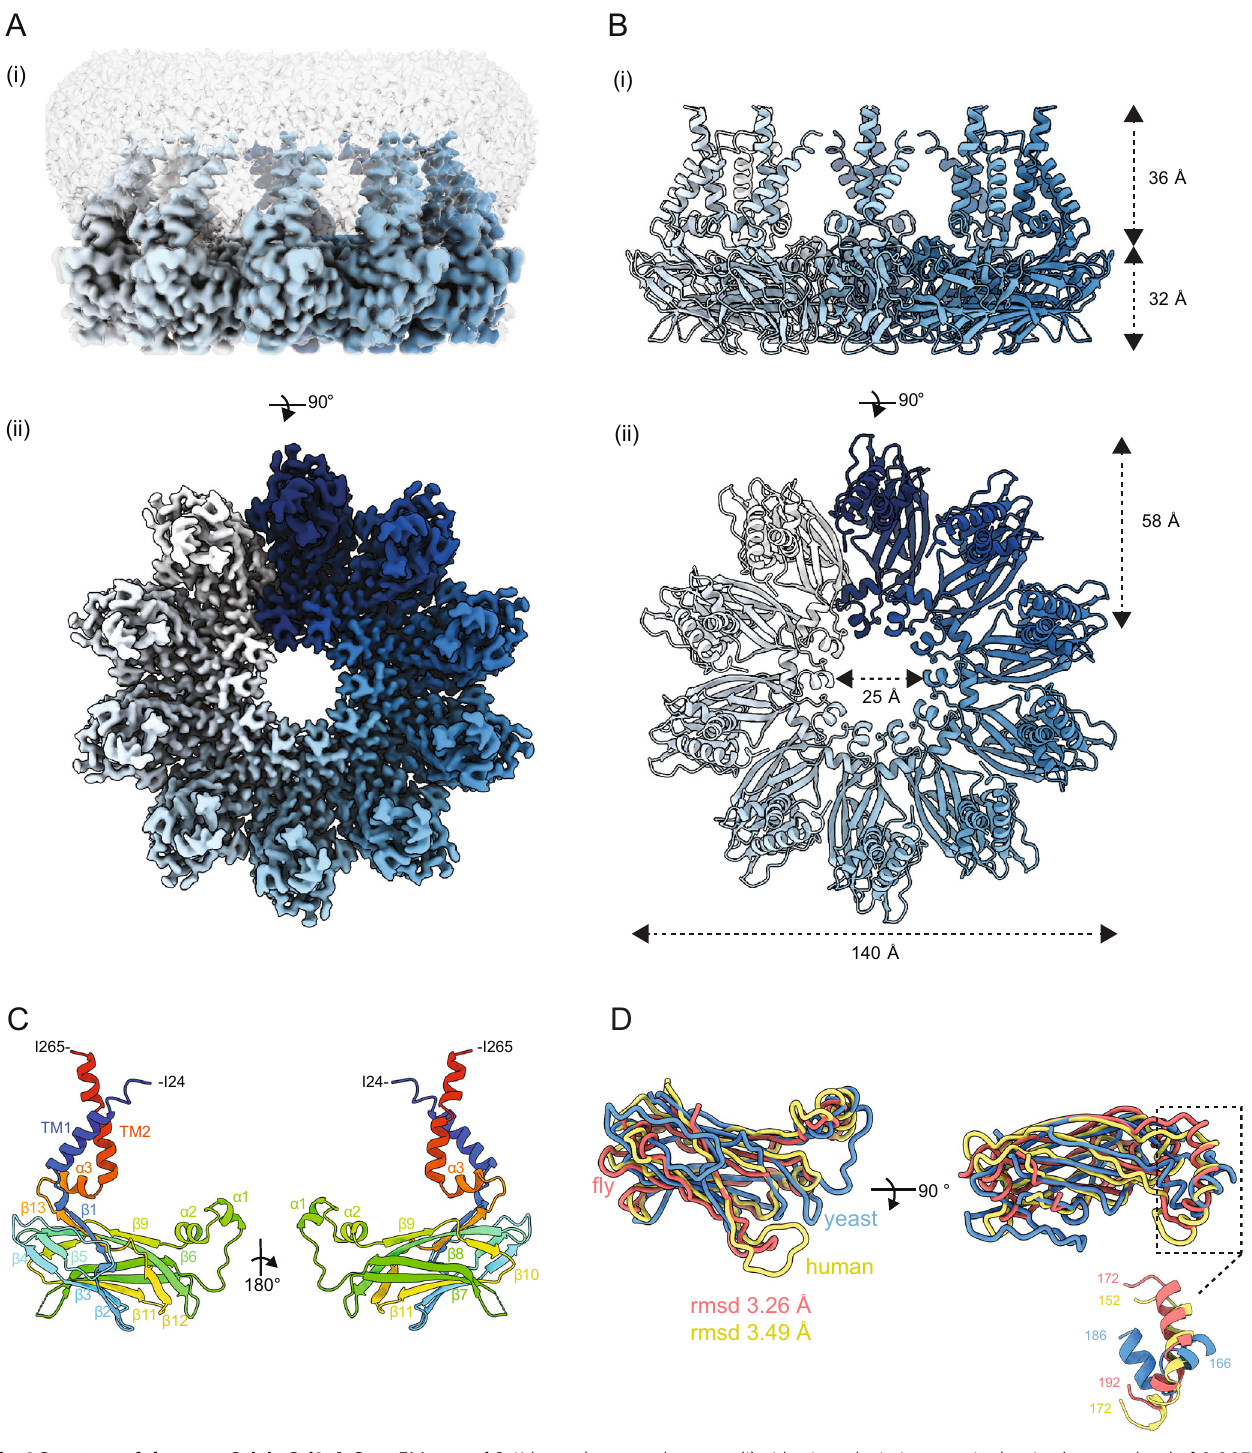
Fig. 1 Structure of the yeast Seipin Sei1. A Cryo-EM map of Sei1 homodecamer shown as (i) side view, depicting protein density (contour level of 0.007) with each Sei1 protomer colored in shades of blue, and the surrounding detergent micelle shown in transparent gray (contour level of 0.005) or (ii) 90- degree rotated view looking down from the cytosol, with detergent micelle omitted for clarity (contour level of 0.007). B Cartoon representation of the Sei1 homodecamer model depicted as (i) side view or (ii) 90-degree rotated view looking down from the cytosol, as depicted in ( A ). Individual Sei1 protomers are displayed in different shades of blue. C Cartoon of Sei1 protomer model colored as rainbow from N- (blue) to C-(red) termini). The various Sei1 domains are indicated: partial transmembrane helices (TM1 and TM2) capped by the short α 3 helix; the luminal β -sandwich ( β -strands 1 – 13); and central helices α 1- 2. D Structural alignment of the luminal domains of yeast (blue; residues 49 – 232), fl y (residues 88-240 of PDB 6MLU; orange), and human (residues 60 – 219 of PDB 6DS5; yellow) Seipin protomers. Indicated RMSD is against the yeast protomer. Inset — detail of the luminal helices protruding towards the ER